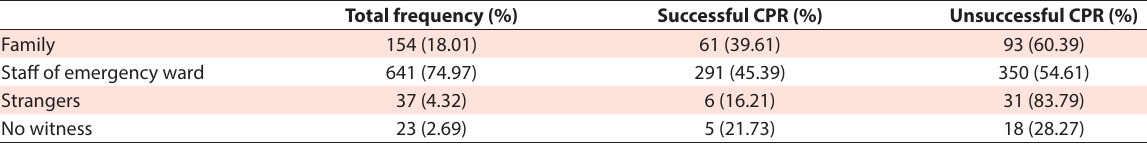
Table 1. Different CPR outcomes regarding witnessed or unwitnessed cardiac arrest